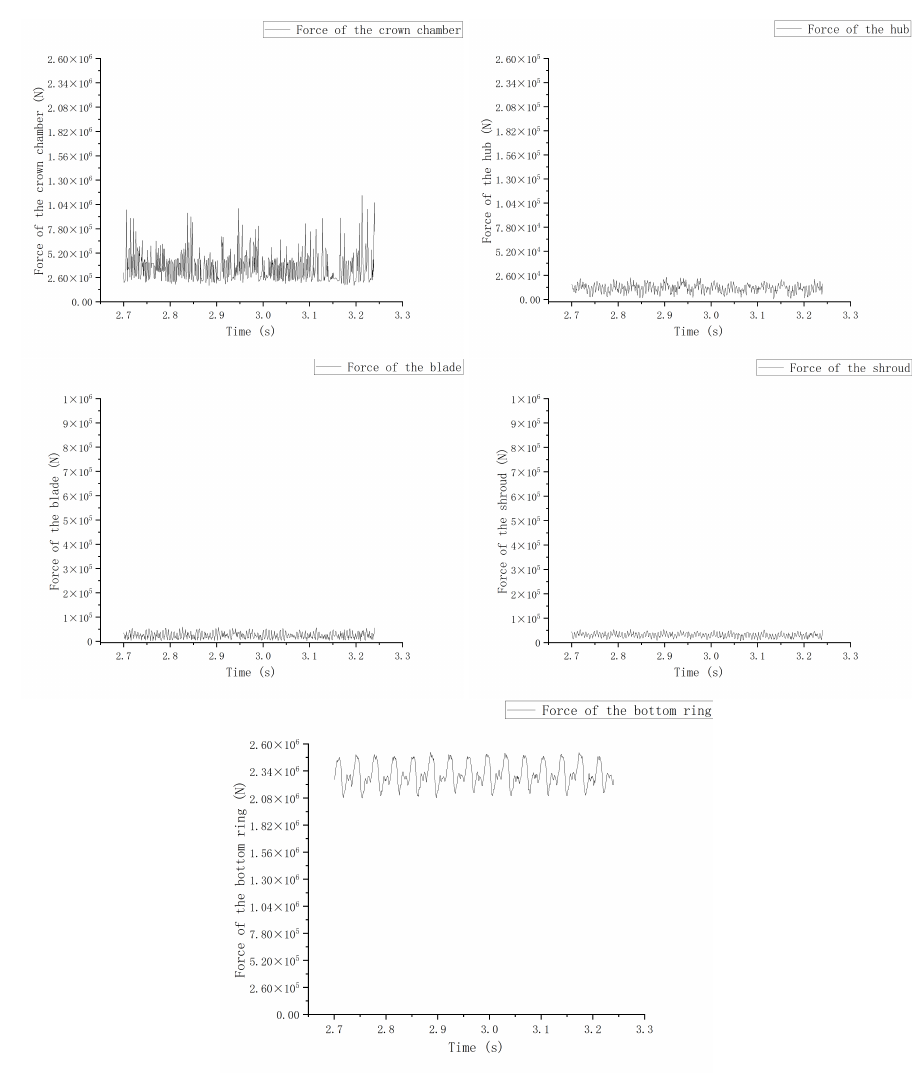
Figure 14. The time domain signals of the radial force